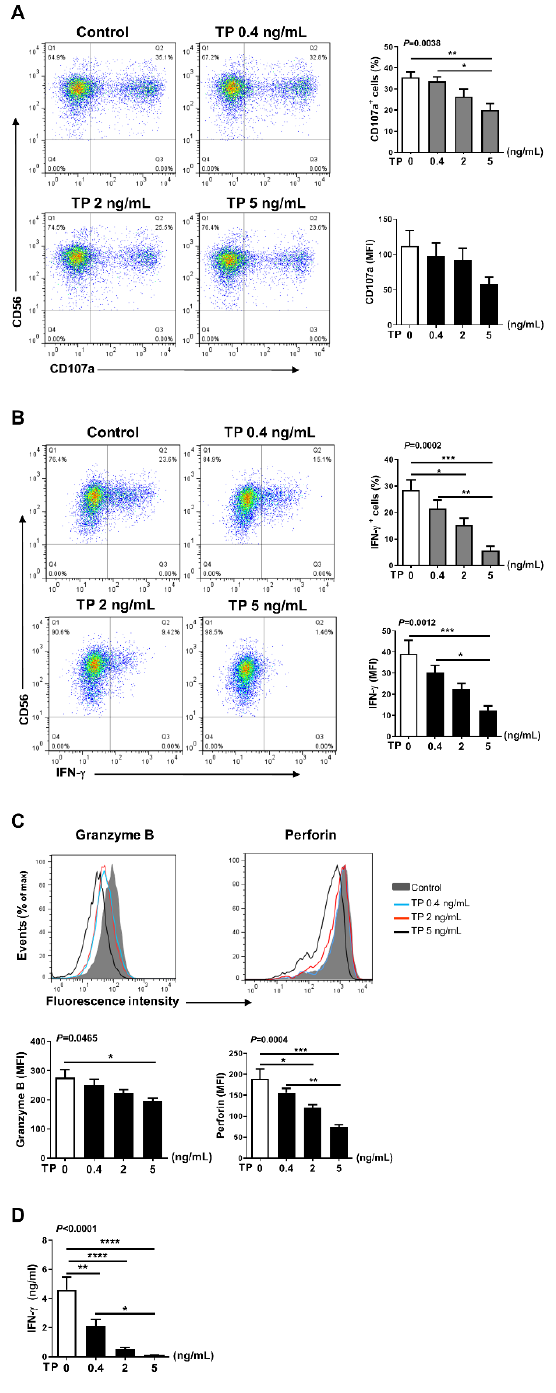
Figure 4. Effects of TP on the function of human purified NK cells. Purified human NK cells were treated with TP as indicated. Supernatants were collected after 24 h, and NK cells were further co-cultured with K562 at a ratio of 2:1 (NK:K562 = 2:1). ( A , B ) Flow cytometric analysis of CD107a was carried out on NK cells. The IFN- γ expression was tested by flow cytometry after cells were fixed and permeabilized. The results including percentage of positive cells and fluorescence intensity (MFI) are shown. ( C ) Granzyme B and Perforin expressions were measured by intracellular staining and flow cytometry. ( D ) The amounts of IFN- γ in supernatants was determined by ELISA. Data were analyzed by one-way analysis of variance with a multiple comparisons test ( n = 4), * p < 0.05, ** p < 0.01, *** p < 0.001, **** p < 0.0001.